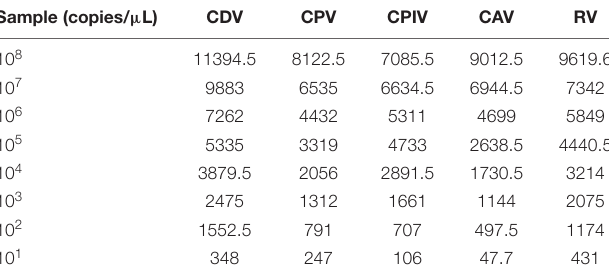
TABLE 3 | MFI values of different recombinant plasmid